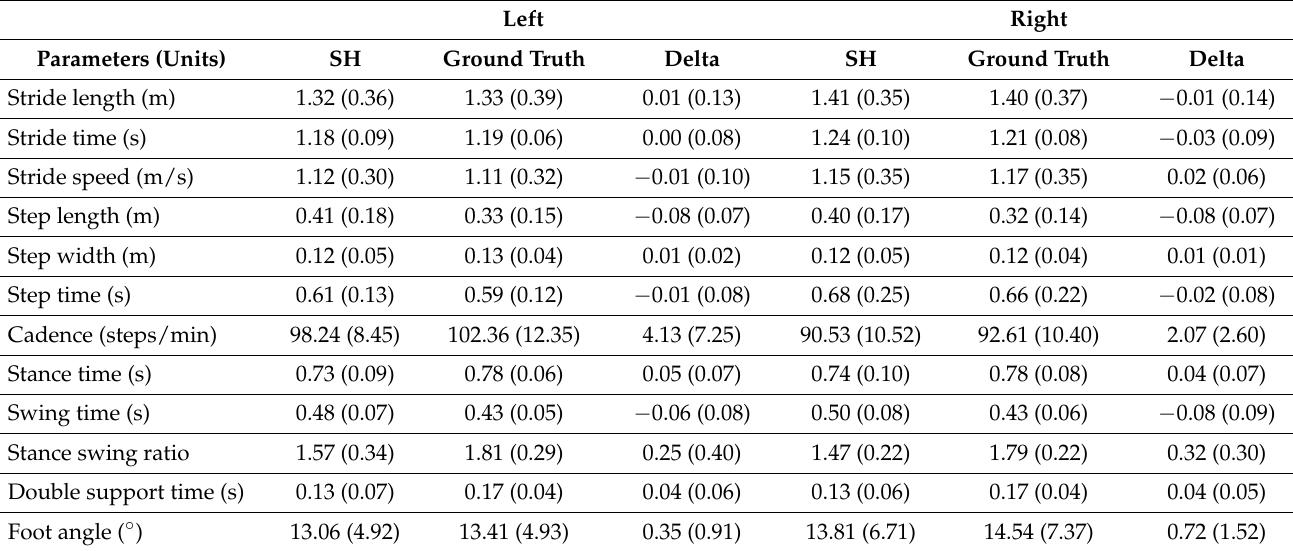
Table 8. Stride parameters for participant one from the Smart Hallway (SH) compared to ground-truth foot-event stride parameters for the walking-turn test (mean and standard deviation in brackets).